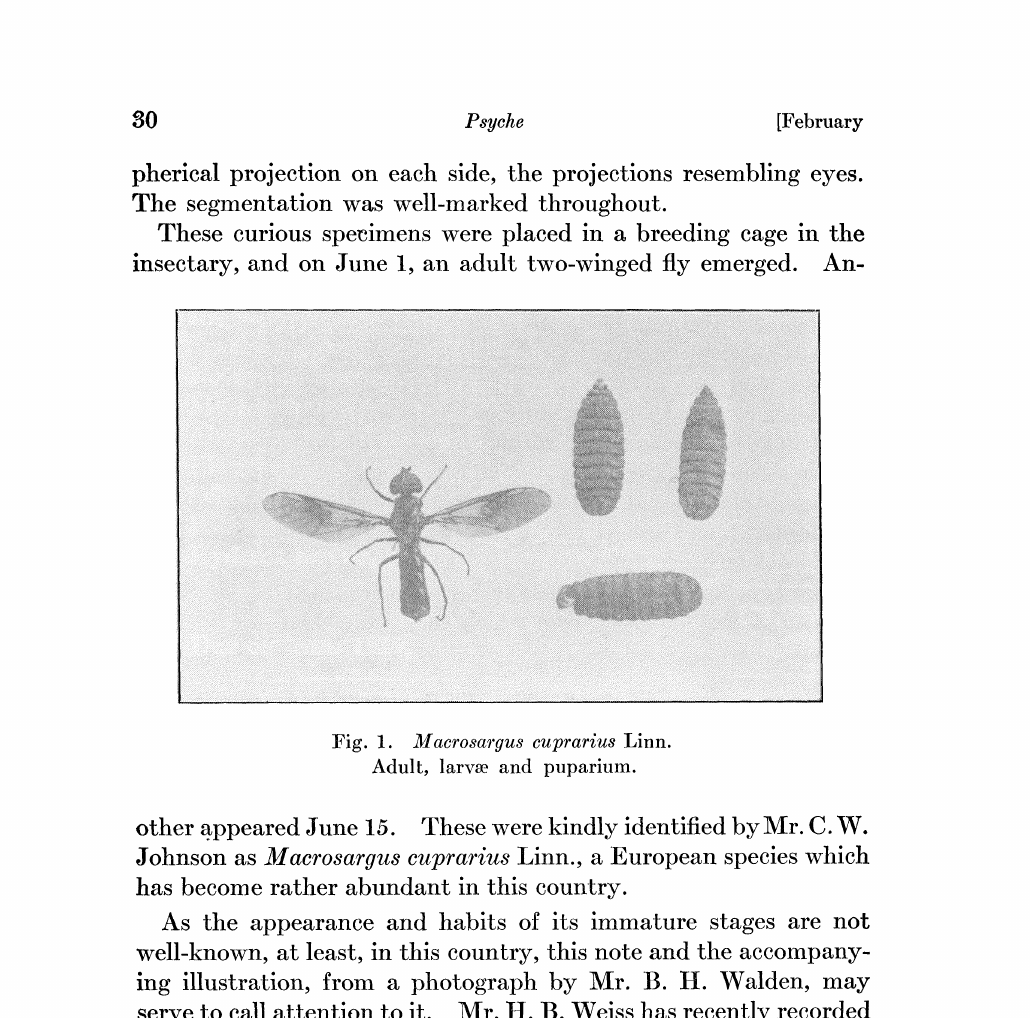
Fig. 1. Macrosargus cuprarius Linn. Adult, larvae and